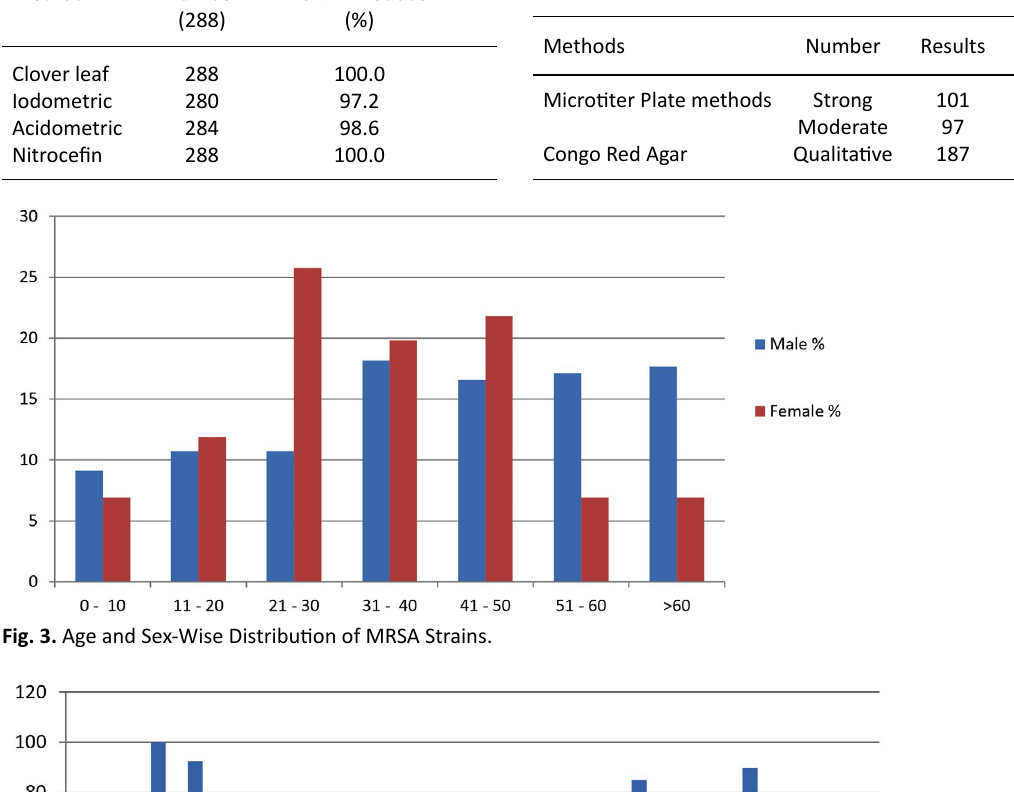
Table 2. Biofilm Production in MRSA